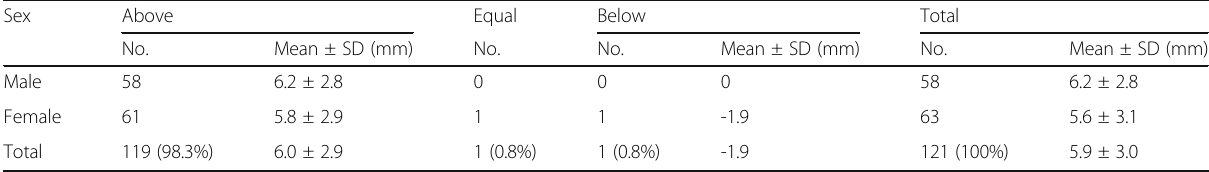
Table 3 Relationship of mandibular lingula to occlusal plane